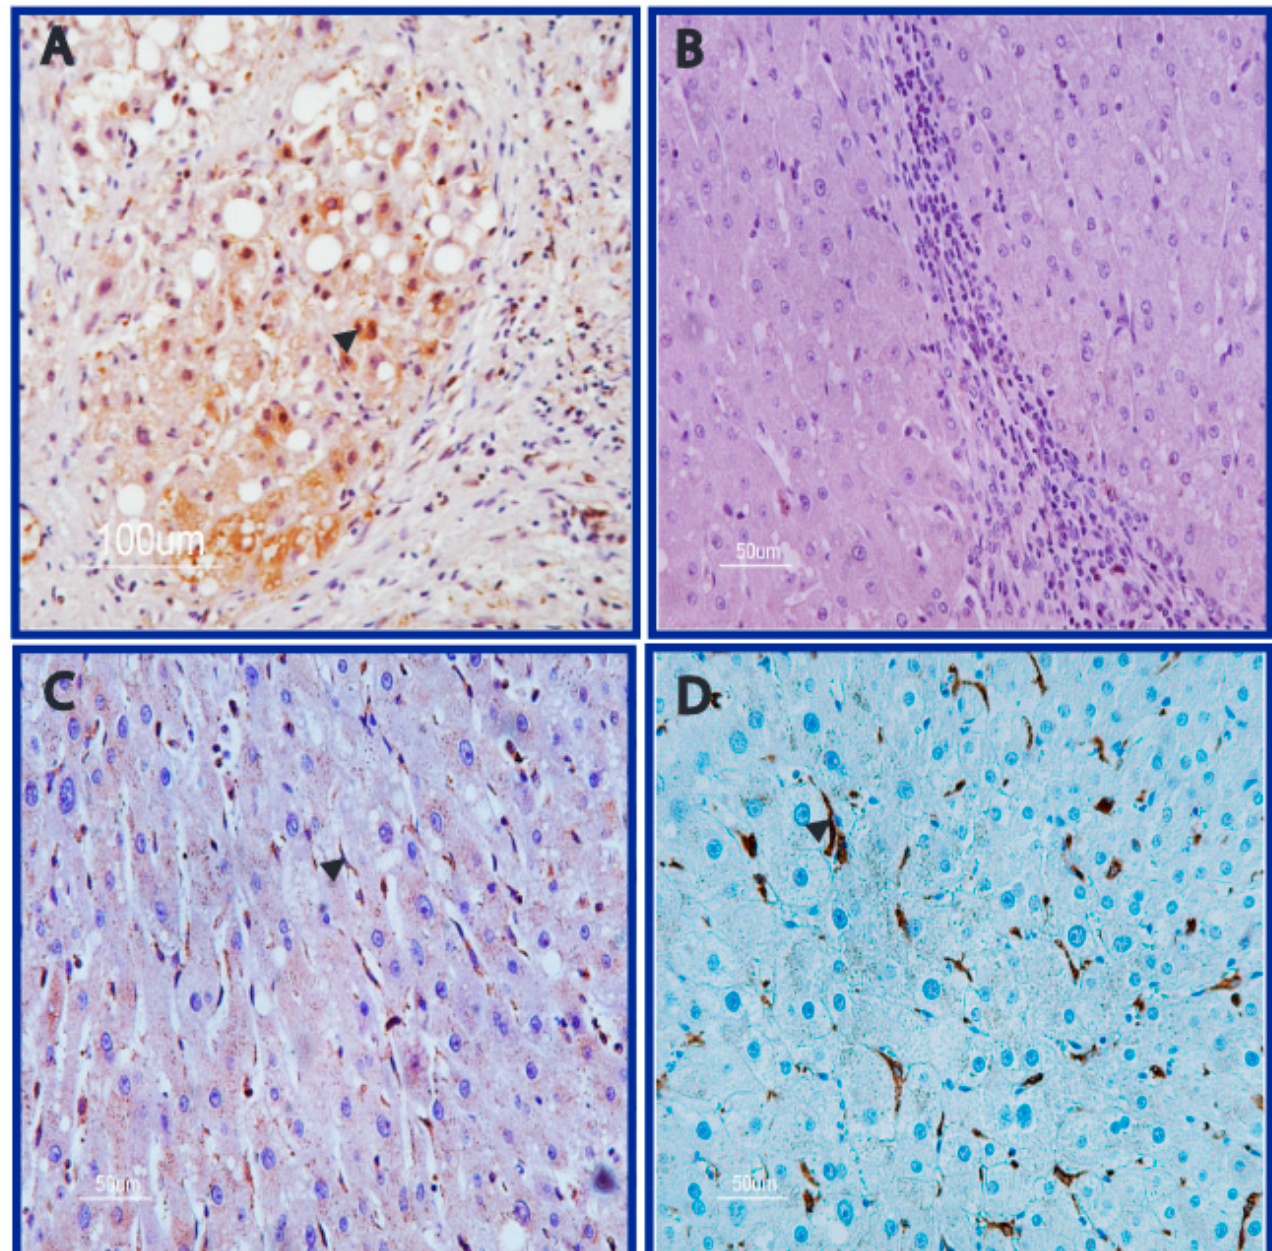
Figure 2. AFB1 staining in human cirrhotic tissue. Representative cases of AFB1adducts immunostaining in human cirrhotic nodules with AFB1 positive hepatocytes were surrounded by septa with positive cells ( A ). Conversely, septa surrounding negative nodules usually did not display AFB1 adducts ( B ). AFB1 adducts were observed also in infiltrating cells identified by CD68 immunostaining ( C , D ). Magnification: ( A ): 10 × ; ( B – D ): 20 ×.